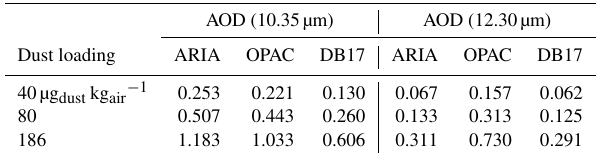
Table 2. Examples of AOD for 10.35 and 12.30µm for three dif- ferent dust loading amounts, using dust RI and optical property assumptions from Table 1 and an assumed dust layer thickness of 2km. AOD (10.35µm) AOD